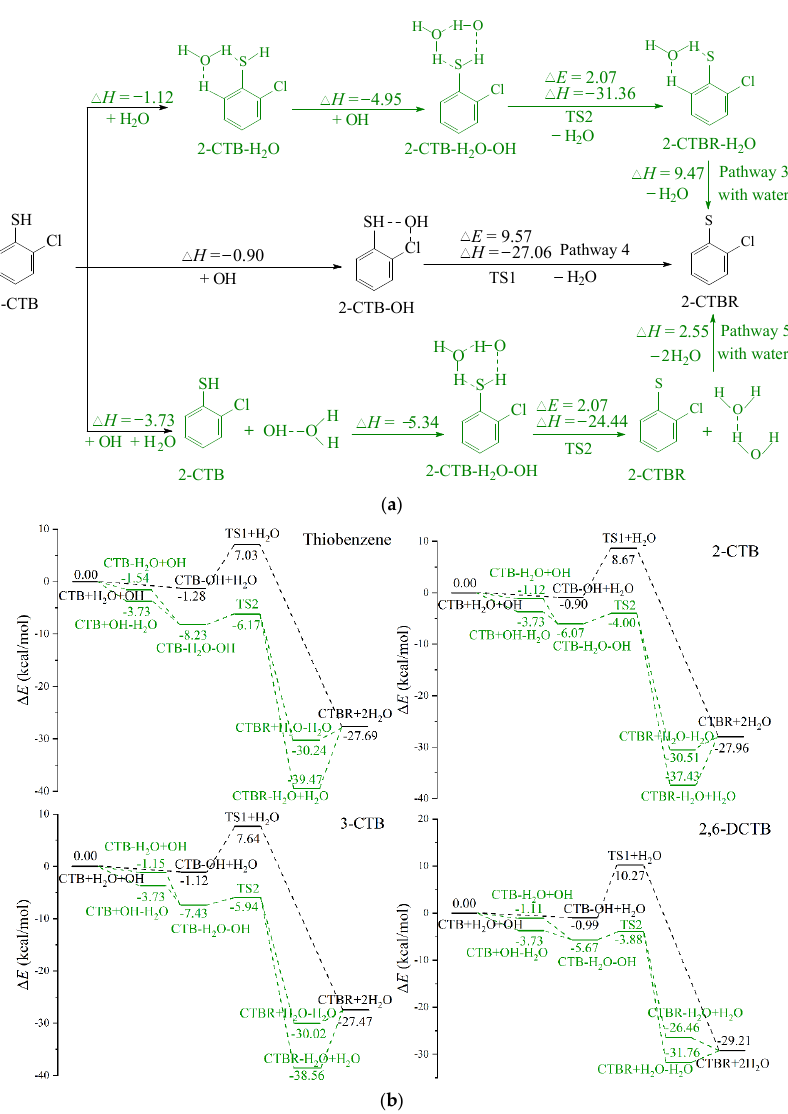
Figure 4. The reaction mechanism ( a ) and schematic energy profile ( b ) of the H abstraction from TBe, 2-CTB, 3-CTB, and 2,6-DCTB by · OH radical in hydrated and non-hydrated cases. ∆ E and ∆ H are calculated at 0